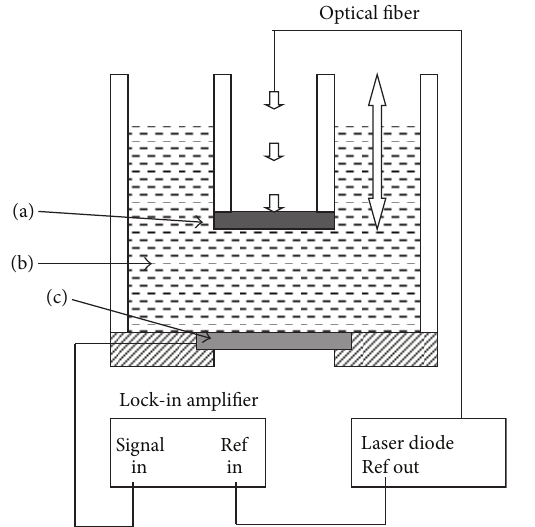
Figure 1: Schematic representation of the experimental setup of TWRC, (a) copper foil, (b) liquid sample, and (c) PE